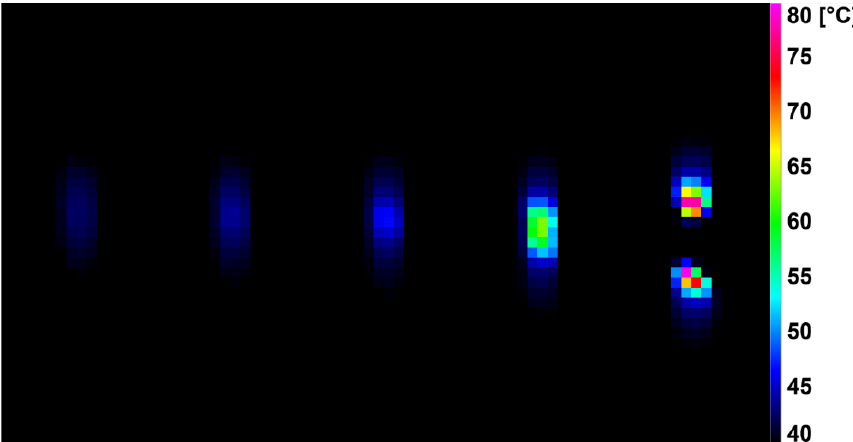
Figure 7. Deformation process of H7 evaluated using IR thermography.